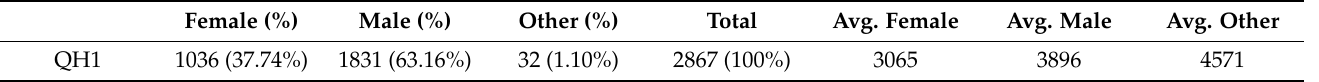
Table 5. Difference of gender in days of play.